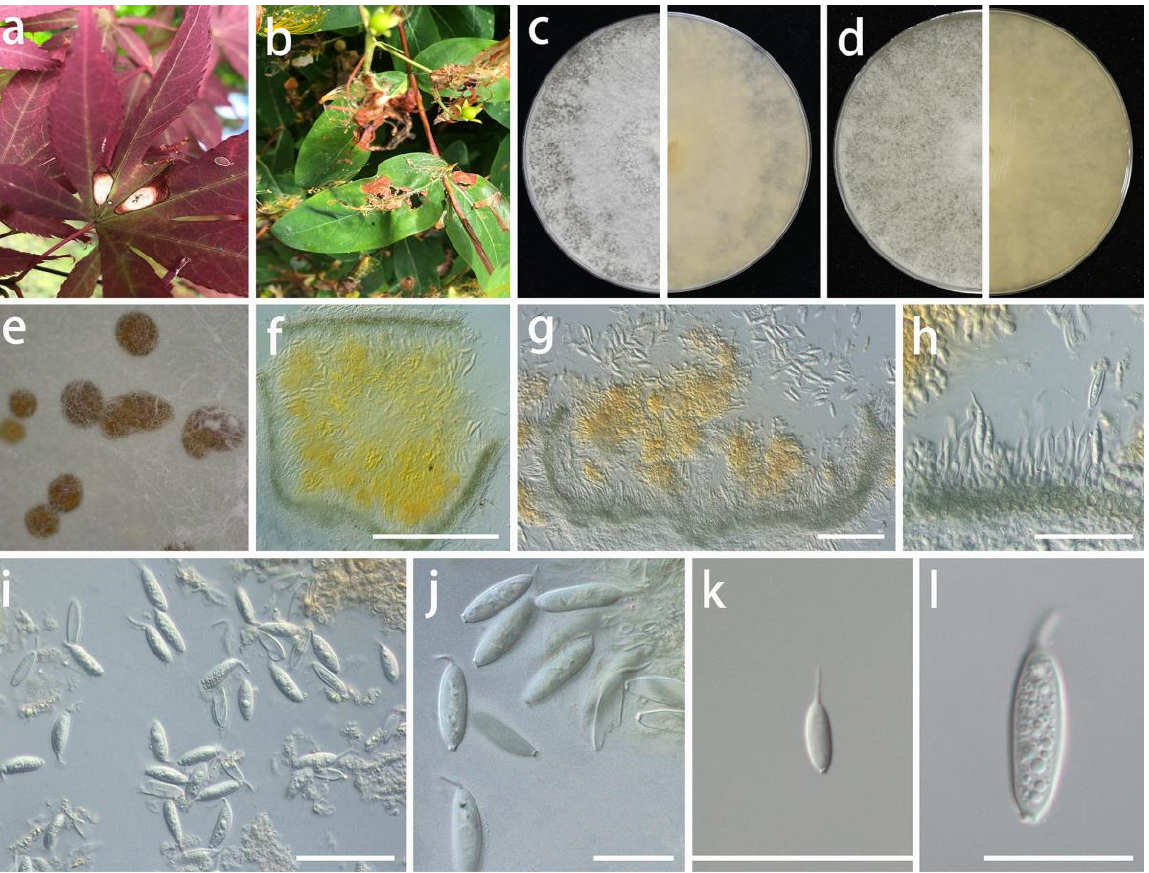
Figure 5. Pseudomastigosporella guizhouensis (GUCC 406.6). Hosts: ( a ) Hypericum patulum ; ( b ) Acer palmatum . ( c ) Colony on PDA after 2 wk at 25 °C (left: above, right: reverse). ( d ) Colony on OA after 2 wk at 25 °C (left: above, right: reverse). ( e ) Mass of conidia. ( f ) Conidioma. ( g , h ) Conidiomata and conidiogenous cells. ( i – l ) Conidia. Scale bars: ( f – i ) = 50 μ m; ( j – l ) = 10 μ m.